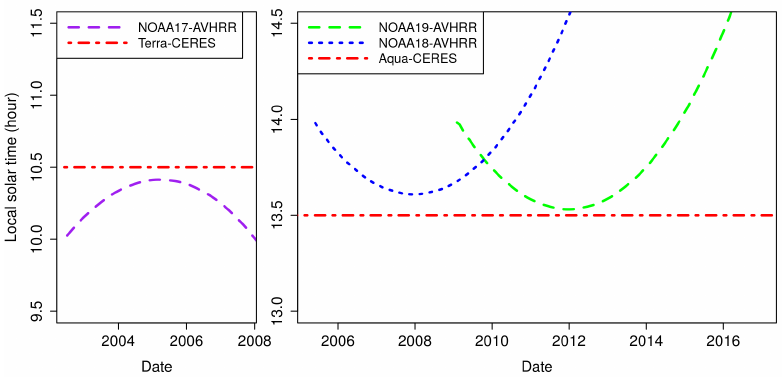
Figure 1. Daytime equatorial crossing time for the relevant satellite